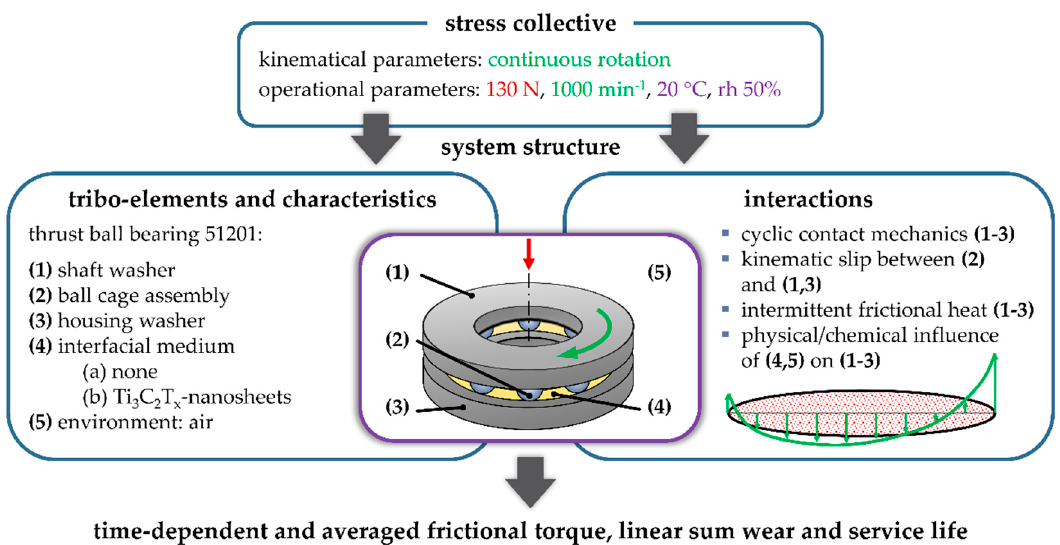
Appl. Sci. 2020 , 10 , x FOR PEER REVIEW Figure 4. Example for a tribological reference method as studied in [26]. Figure 4. Example for a tribological reference method as studied in [26].